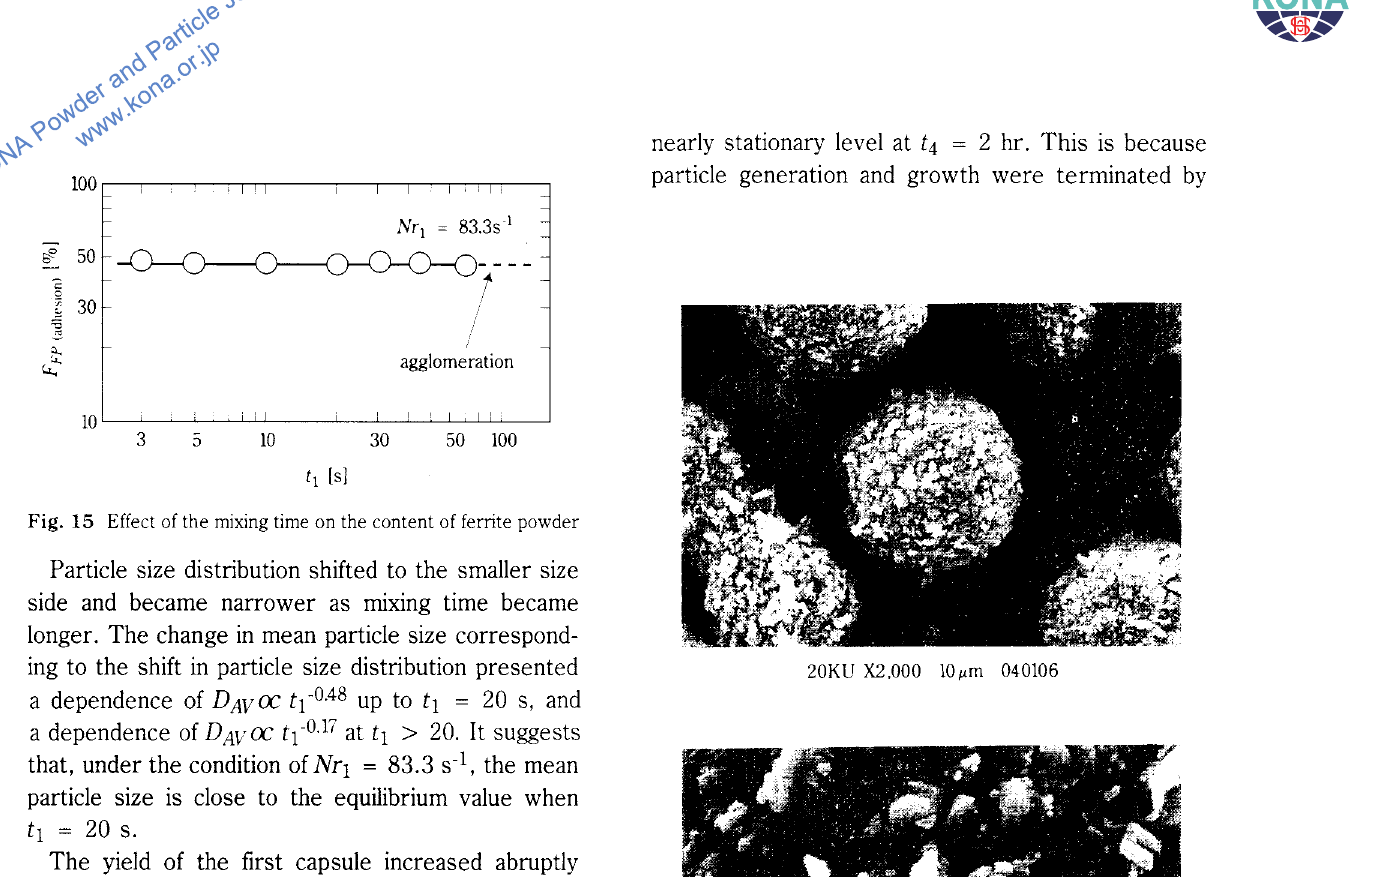
Fig. 16 SE:vl photograhs of the first